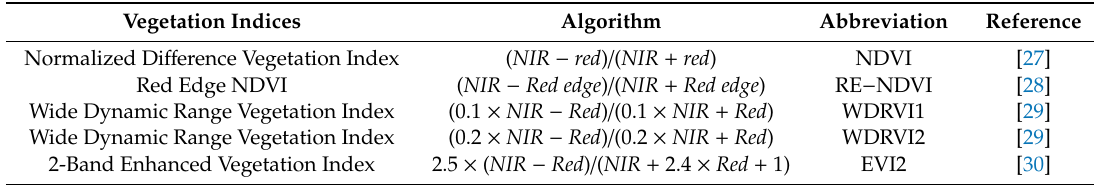
Table 2. Vegetation indices considered in this study that concern prediction of leaf area index (LAI). Vegetation